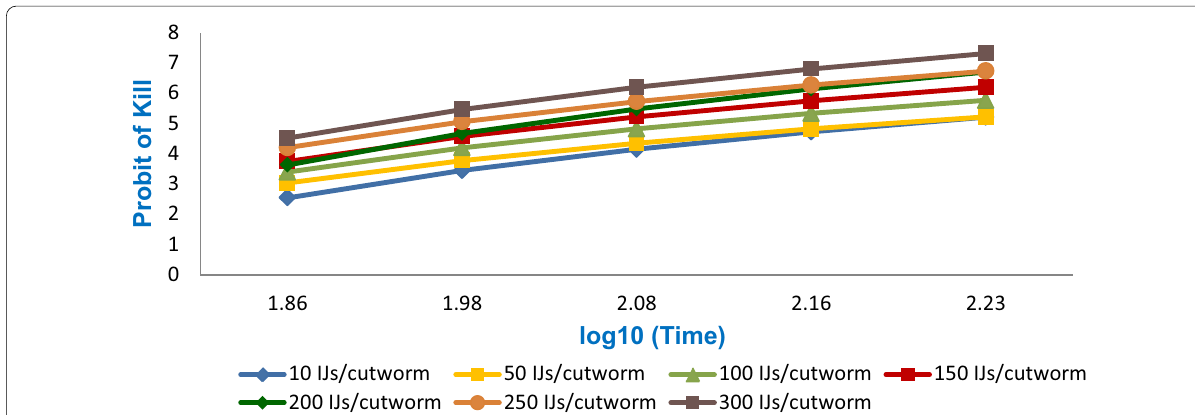
Fig. 3 Time response curve of A. ipsilon larvae exposed to H. bacteriophora during different time intervals and concentrations